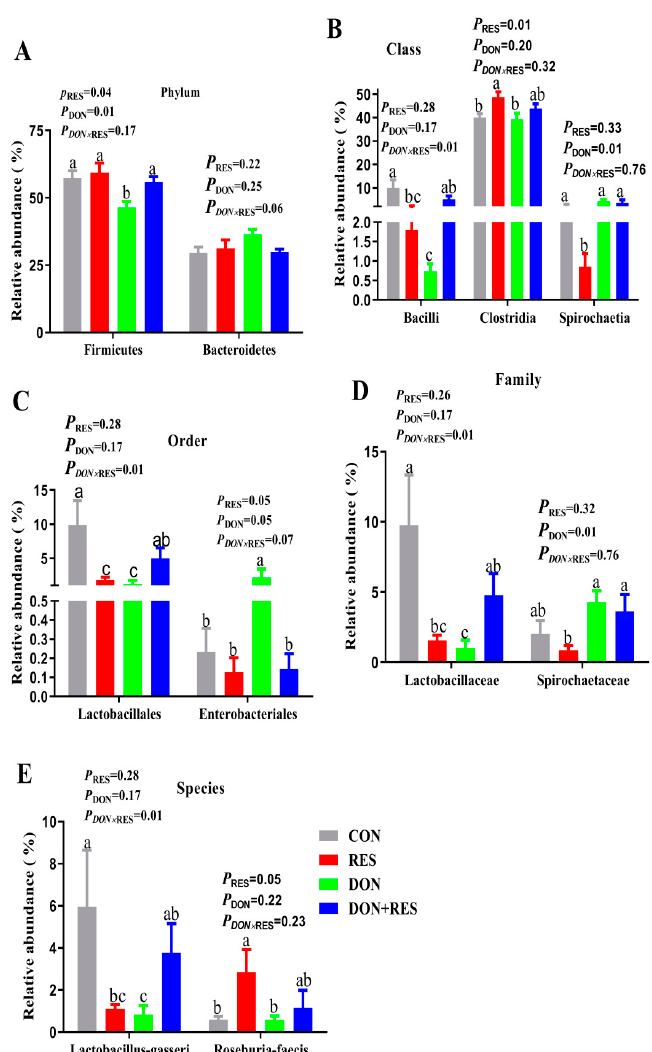
Figure 2. Effect of resveratrol supplementation on the relative abundance of gut microbiota in DON-challenged piglets. The significantly different microbial ( A ) at phylum level (top 10), ( B ) at class level (top 10), ( C ) at order level (top 10), ( D ) at family level (top 10) and ( E ) at species level (top 10) were showed in the different treatment groups. Data are presented as means and pooled SEM, n = 8; labeled means in a row without a common letter differ, p ≤ 0.05; CON, control; DON, deoxynivalenol; DON + RES, combination of deoxynivalenol and resveratrol; RES, resveratrol.